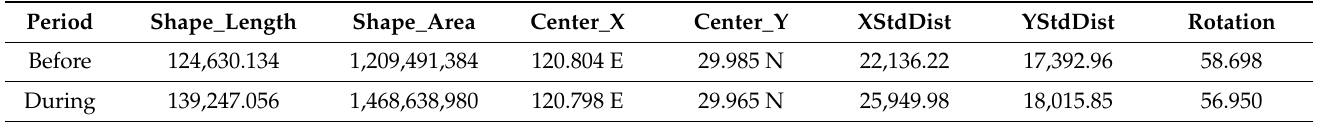
Table 2. Comparison of characteristic data of the standard deviation ellipse of the activity trajectory of confirmed cases during the incubation period and outbreak period.